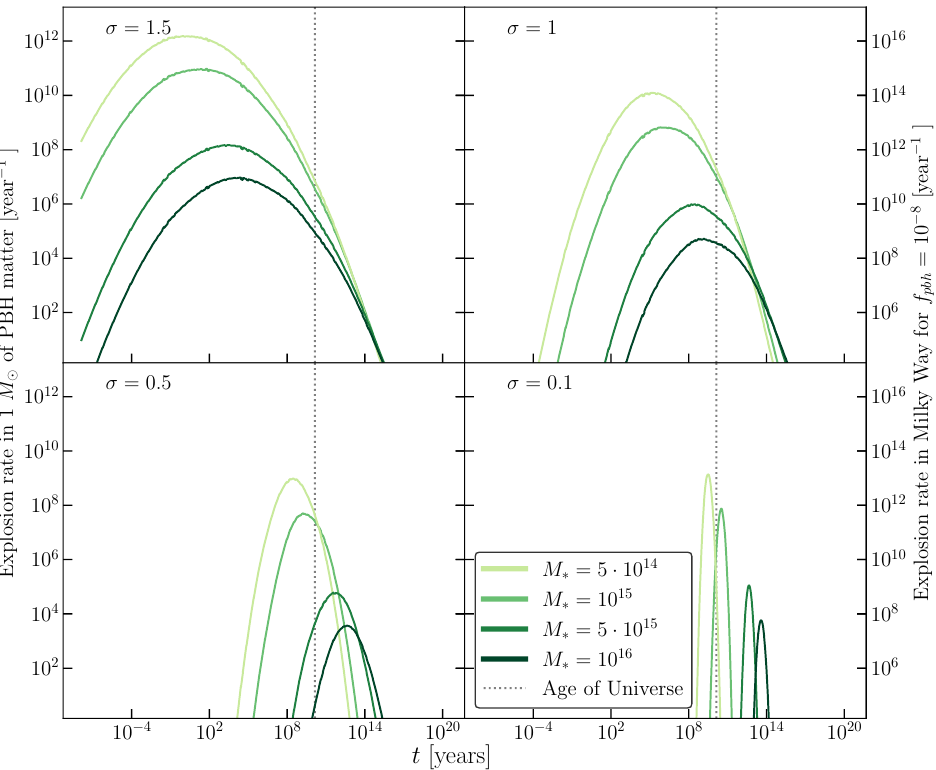
Figure 5: The explosion rate of PBHs over time for sixteen distributions with varying ∼ 10 − 8 . The rate is given in terms of values of σ and central mass M ∗ and f PBH number of explosions per solar mass of PBHs. The second vertical axis gives the explosion rate in yearly numbers for the Milky